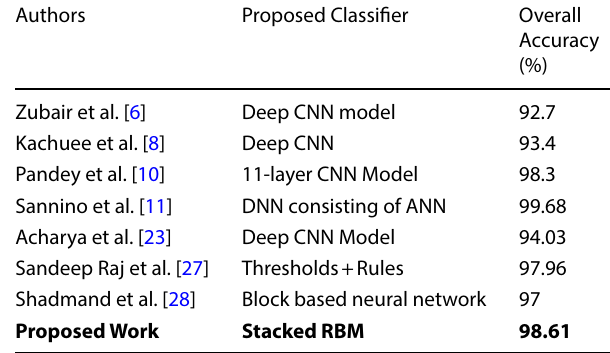
Table 7 Performance Comparison table for Patient Independent Data of various classifiers with our classifier